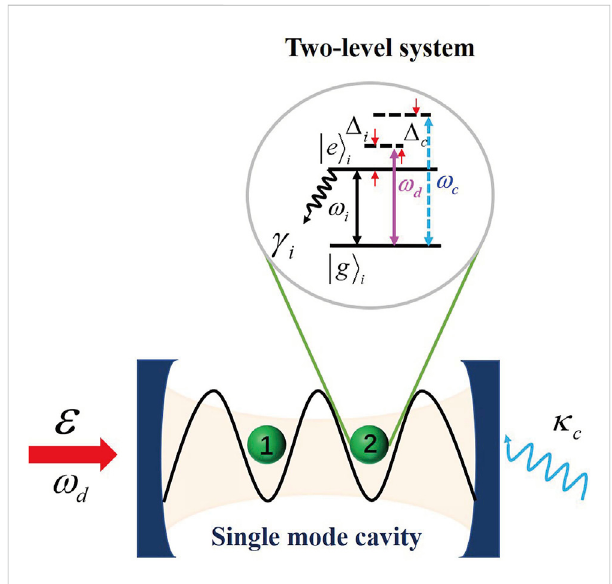
Schematic illustration of the two-level quantum emitter (QE) – cavity QED system with the cavity-mode frequency ω c and QE i resonant frequency ω i . A classical fi eld with the intensity ε and the angular frequency ω d is used to drive the cavity. Here, | g 〉 i and | e 〉 i represent the ground state and excited state of QE i , respectively. κ istheeffectivedecayrateofthecavity,and γ i isthedecayrateofQE